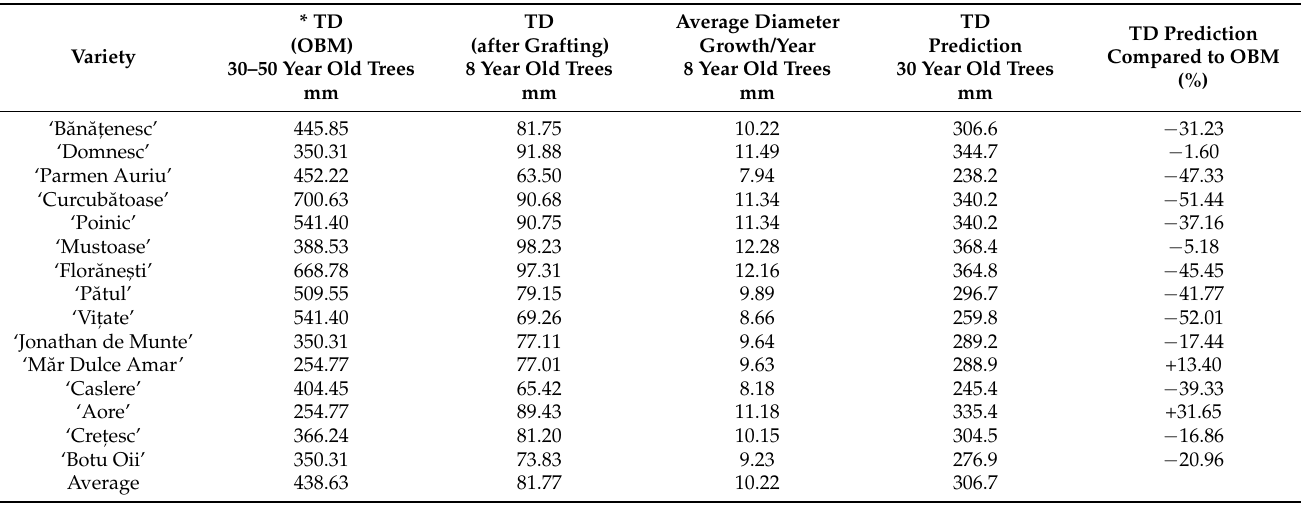
Table 1. Trunk diameter differences before and after grafting. Trunk prediction for the grafted